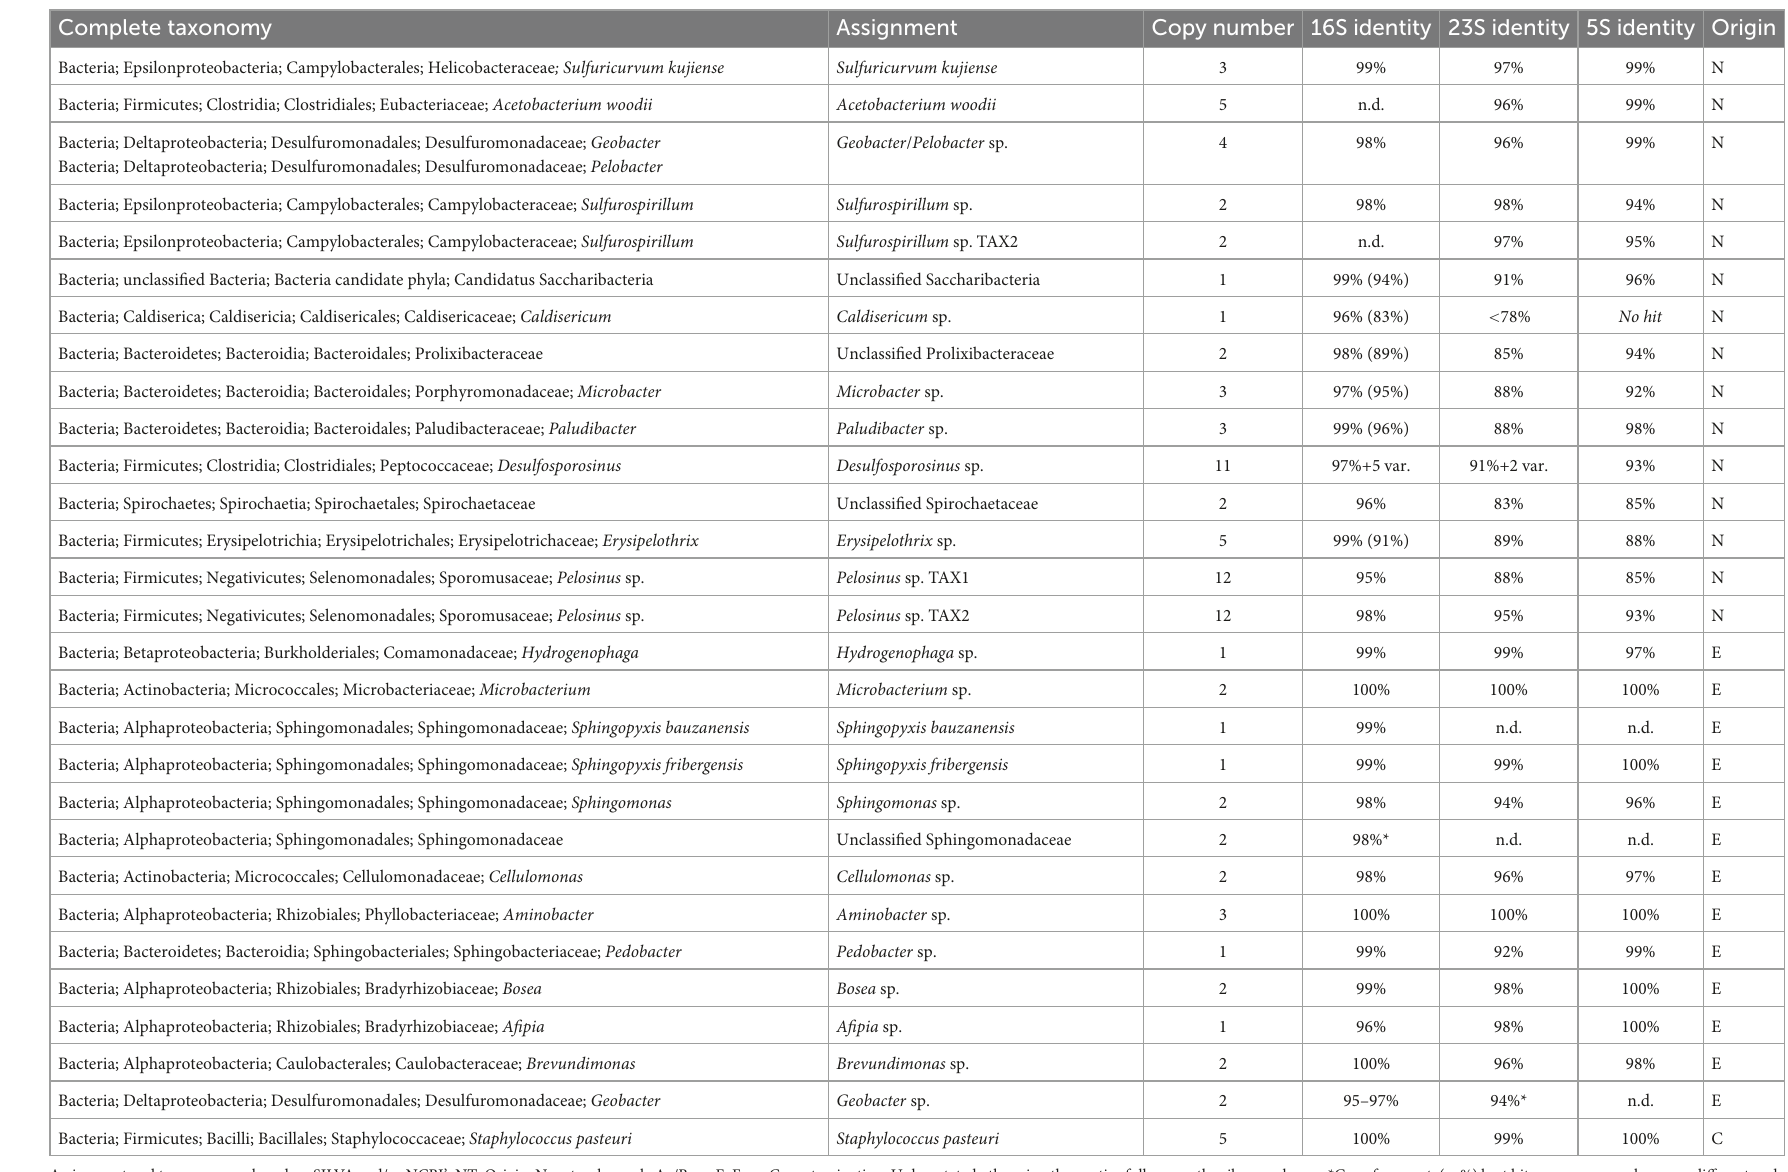
TABLE 3 rDNA contig assembly results. Complete